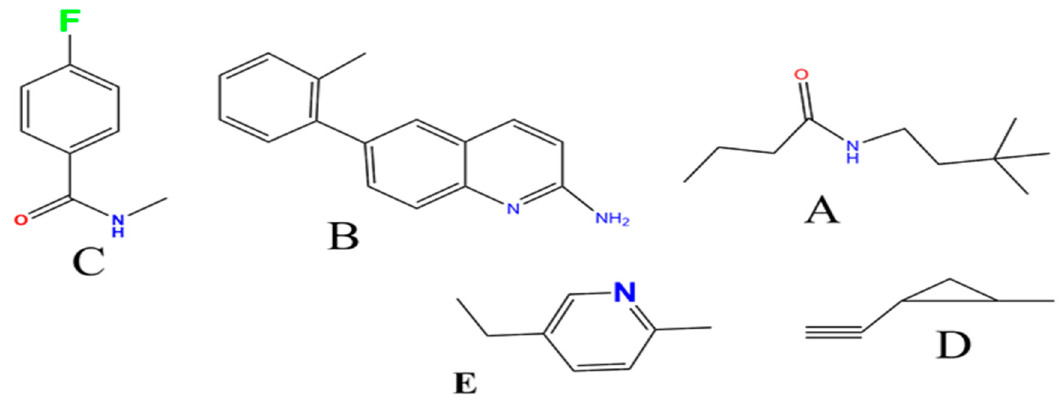
Figure 7. Structure of the fragments in Inhibitors 1, 2, 3 and 4. ( A ) the alkyl chain fragment with amide; ( B ) phenyl rings attached to amidine group; ( C ) Flour and amide attached to the phenyl ring in para position; ( D ) the fragment with Л cloud and cyclic ring; ( E ) pyridine fragment. The hydrophobic interactions Tyr71, Val69, Gly13, Gly230. Phe108, Leu30, and Ile118 are common in all 68J, 68K, 68L, and 68M inhibitors, and all display hydrophobic contacts with residues. The nitrogen containing heterocycles are often referred to as the aspartyl binding motif; see Figure 8.